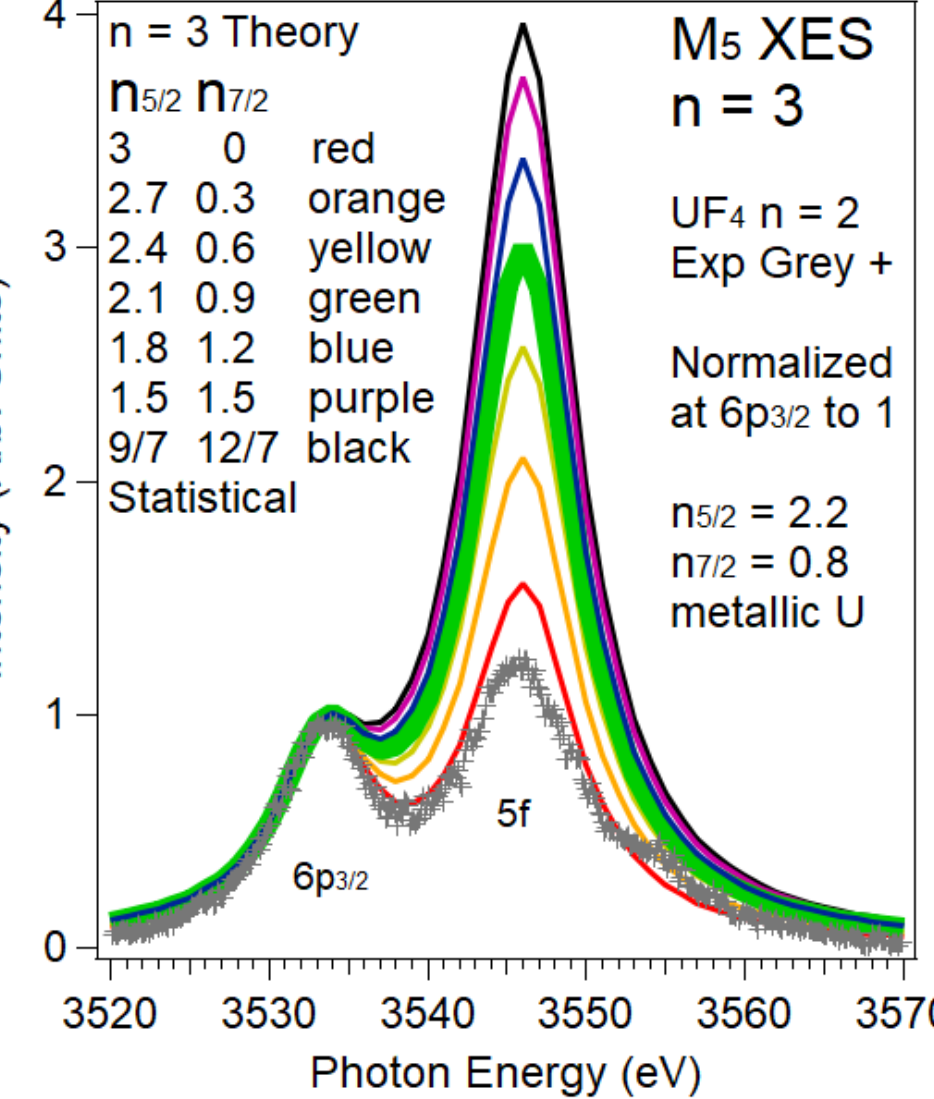
Figure 13. Shown here is the experimental M 5 XES spectrum of UF 4 and the simulated spectra for n = 3 and various values of n 5/2 . The simulation used normalized Lorentzian line shapes, with a half-width at half-max of Γ . For the 6p 3/2 : Γ = 3.5 eV. For the 5f peak, Γ = 4 eV. Taken from Reference [17].